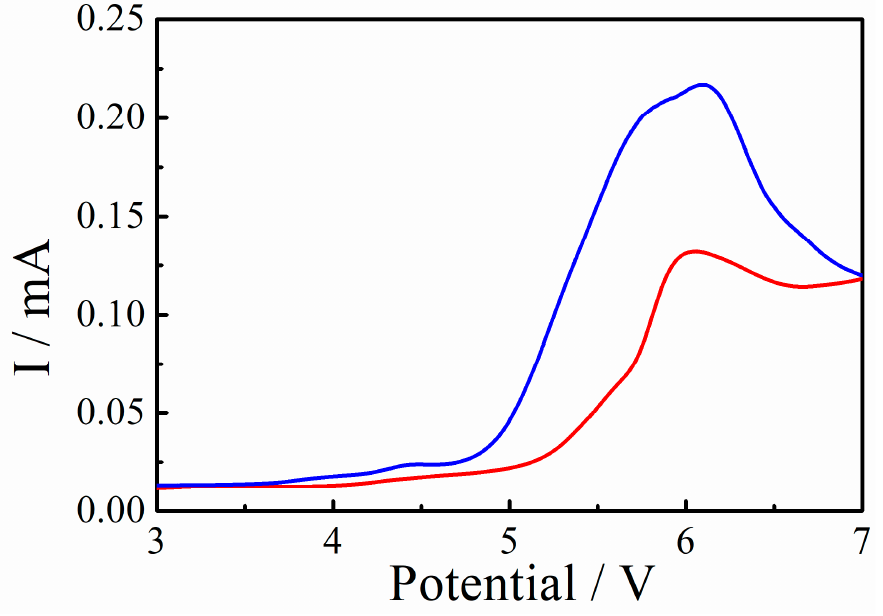
Figure 6. The linear voltammetry curves of the comb ‐ like PCL ‐ based GE (red) and traditional LE (bule) at 25 ◦ C.